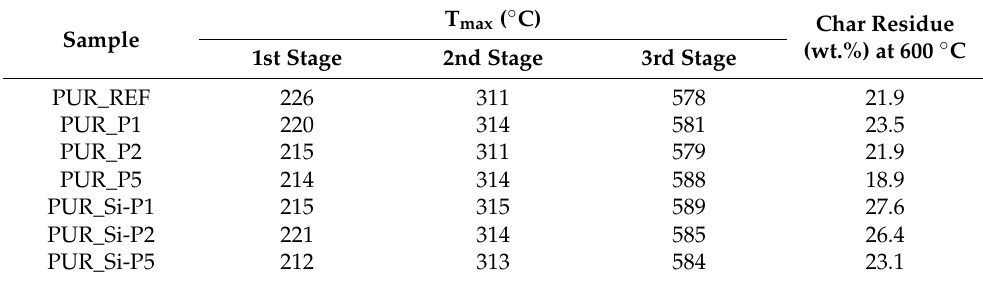
Table 2. Results of the thermal stability of PUR